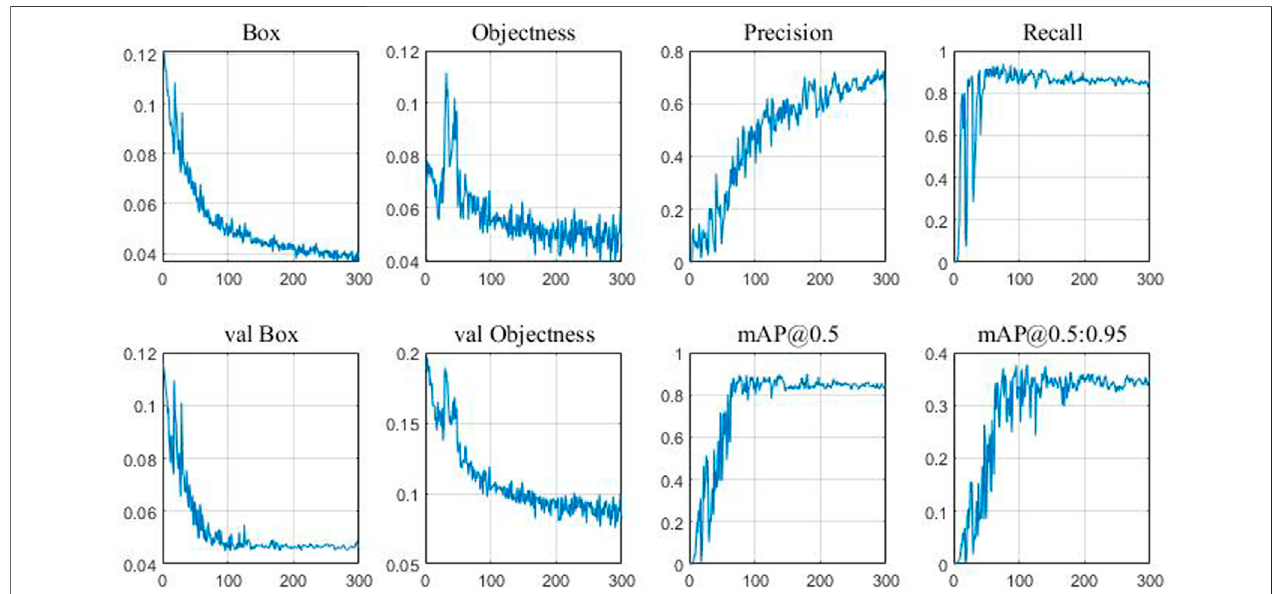
FIGURE 9 | Visualization of training